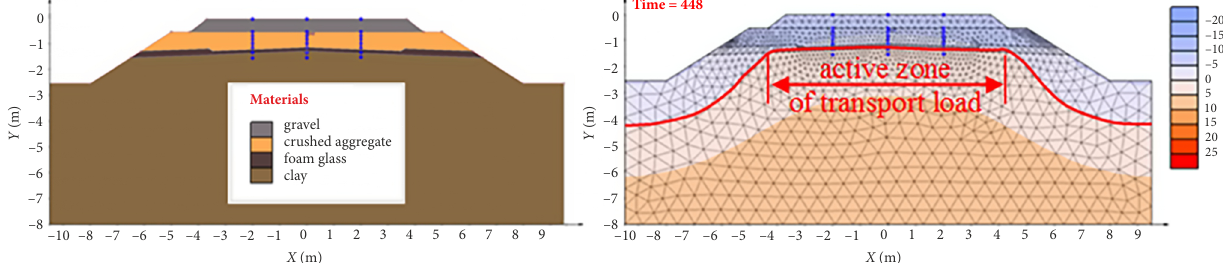
Figure 9. Numerical model 2: design of different thicknesses of the foam glass layer in the sub-ballast layers with respect to the applied climatic load I F = 1400 °C, day and θ m = 2 °C (left); day of achieving the maximum freezing depth of the structural layers of the numerical model (right)